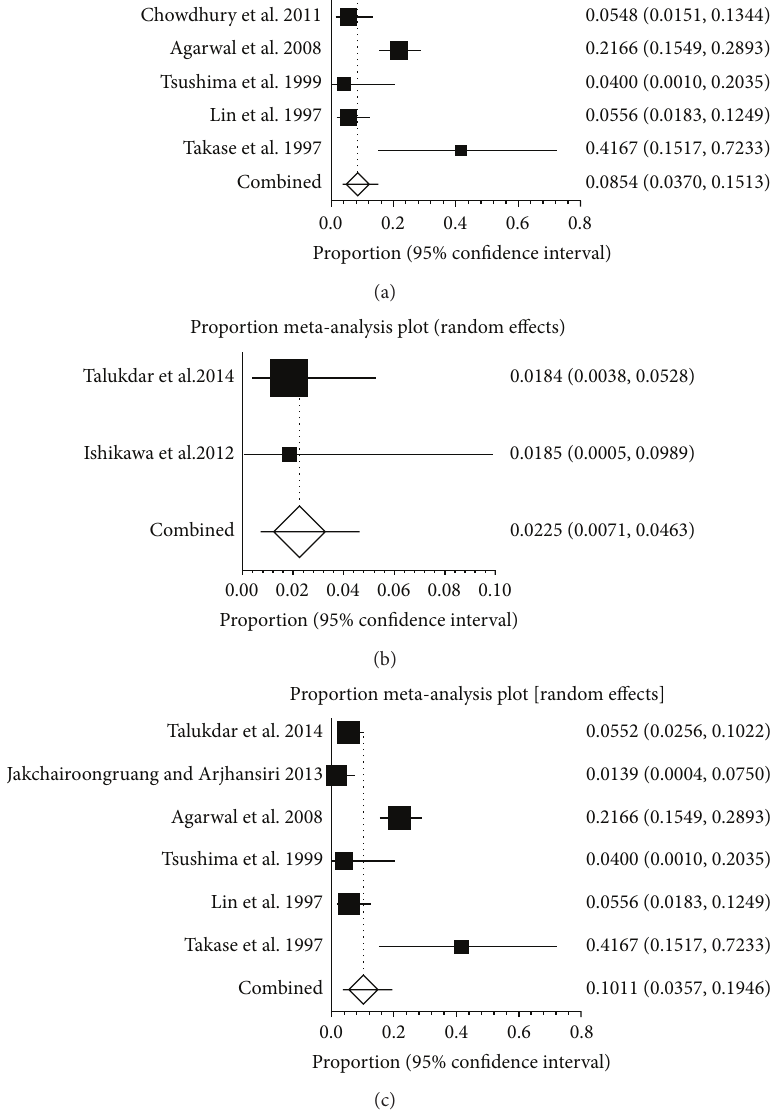
Figure 10: (a) Forest plots showing the prevalence of splanchnic vein thrombosis (SVT) in Asia. (b) Forest plots showing the prevalence of portal vein thrombosis (PVT) in Asia. (c) Forest plots showing the prevalence of splenic vein thrombosis (SlpVT) in